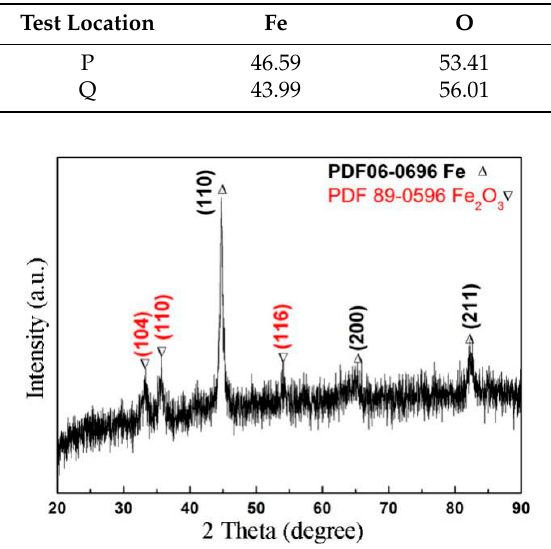
Figure 13 XRD pattern at the worn pin surface when the RD was not used. Figure 13. XRD pattern at the worn pin surface when the RD was not